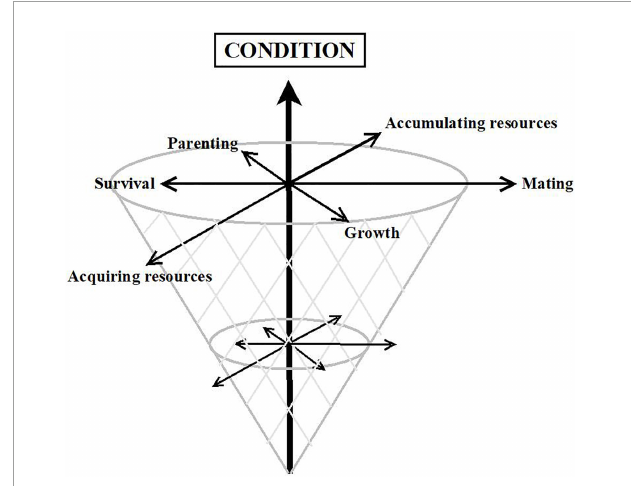
FIGURE4 Cone model reflecting condition on the vertical axis and alternative strategies on the horizontal